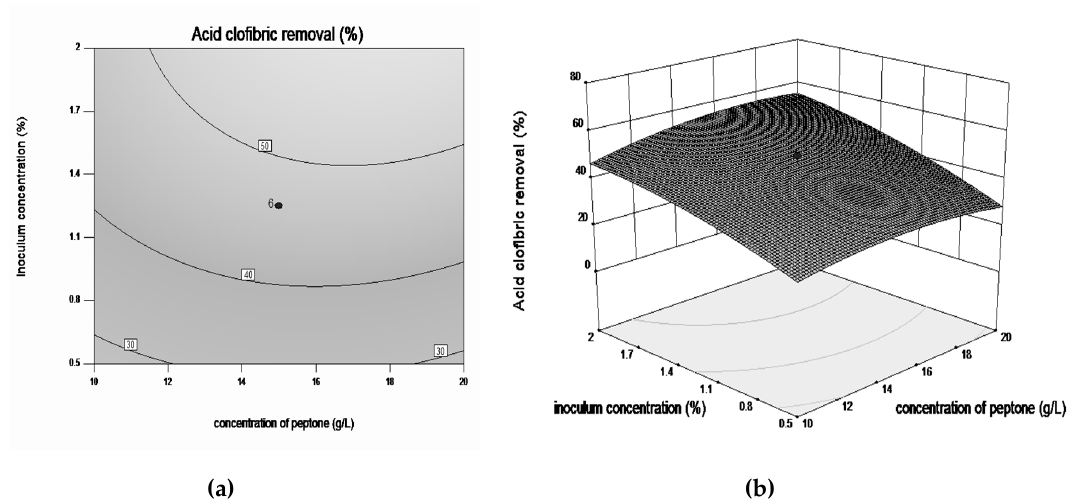
Figure 4. Contour plot ( a ) and three-dimensional surface plot ( b ) showing the e ff ect between inoculum concentration and concentration of peptone on CLF biodegradation by Trametes pubescens